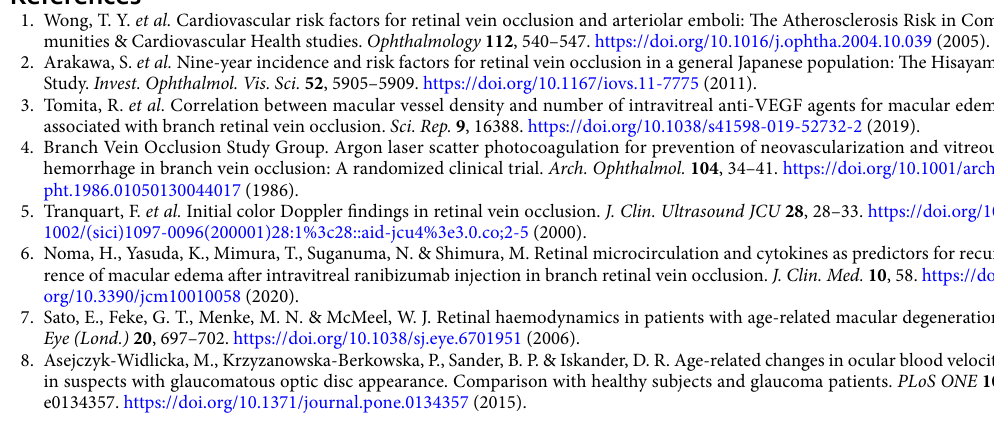
Variable Ratio of BOM of retinal artery in BRVO affected retinal area to